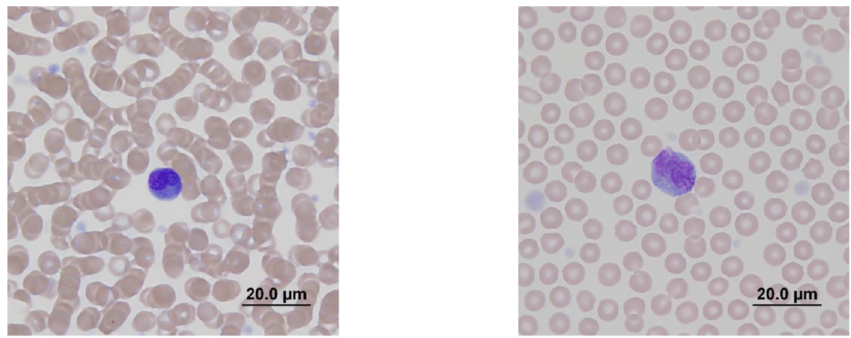
Figure 2. Direct smears of peripheral blood from dogs 1 (left micrograph) and 2 (right micrograph) showing examples of atypical cells, most consistent with lymphoid origin. These cells are intermediate to large in size with low volumes of basophilic cytoplasm, occasionally containing few small clear vacuoles. Nuclei in these two cells are cleaved to binucleate or lobular with clumped chromatin. Modified Wright stain. Bar = 20.0 µm.